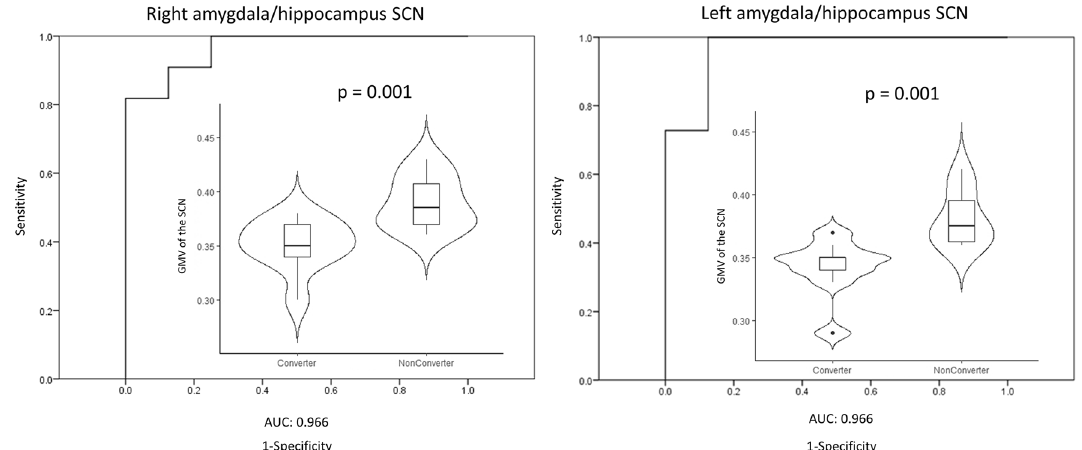
Figure 3. Longitudinal results on the GMV of bilateral amygdala/hippocampus SCN. ROC curve with AUC = 0.966 and 0.966 respectively for GMV of right and left amygdala/hippocampus SCN of